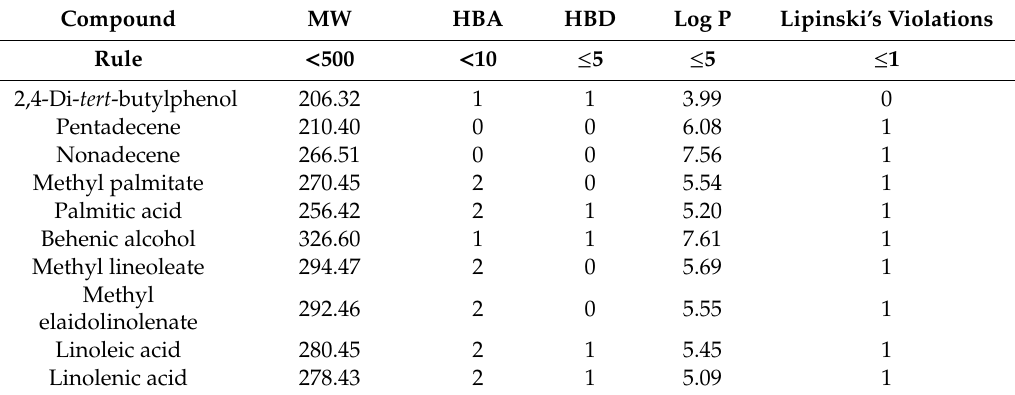
Table 8. Physicochemical properties of the compounds identified in the dichloromethane extract (DTL) of T. leucostaphylum